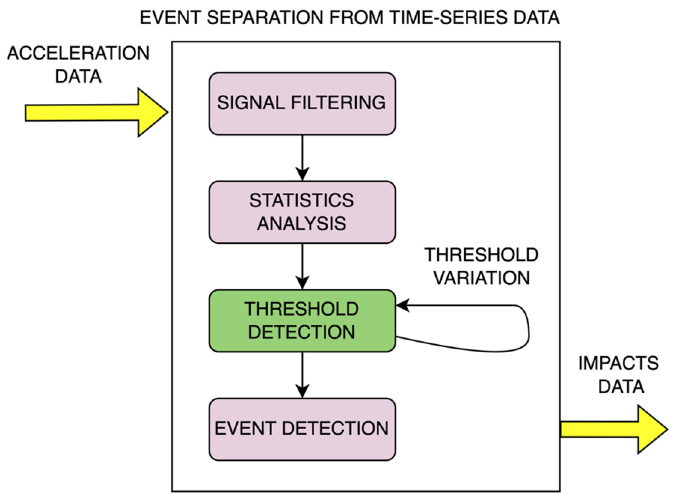
Figure 9. Flowchart of the proposed solution for event data detection.